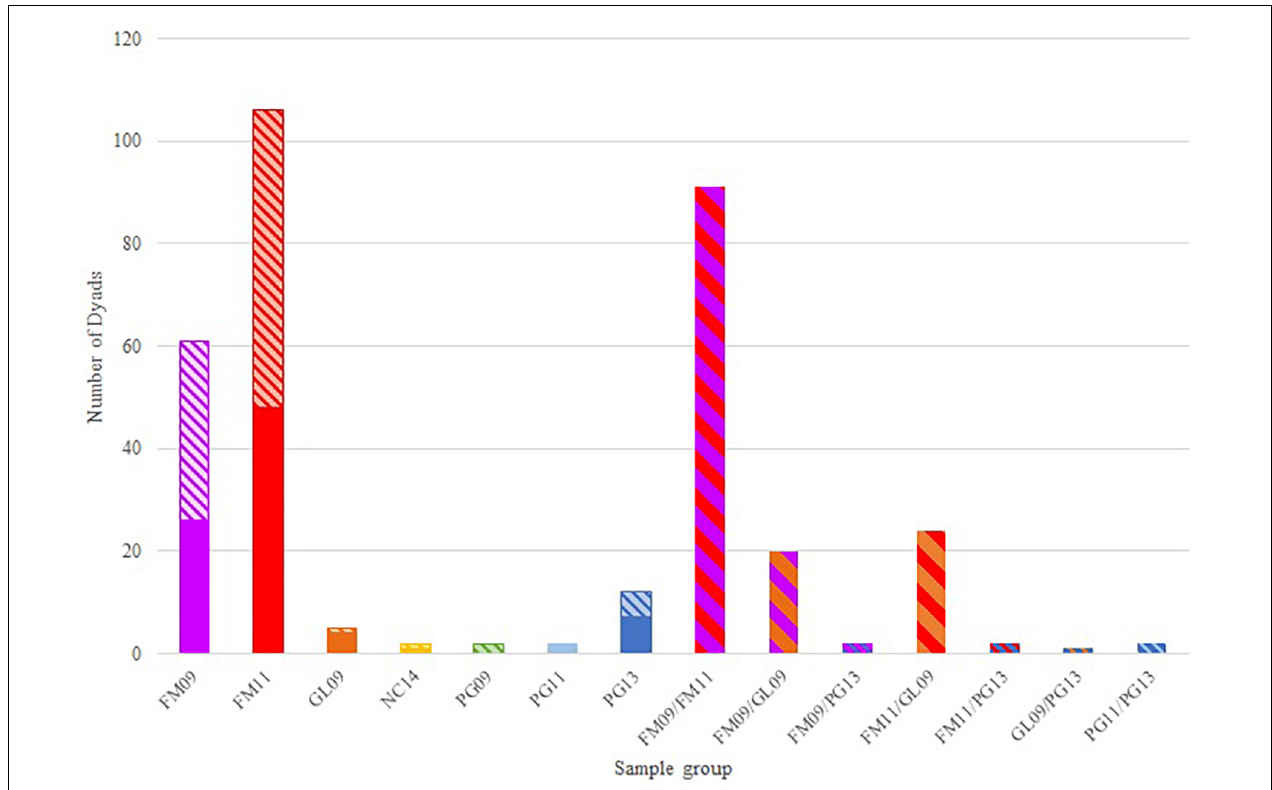
FIGURE 5 | All sibling dyads identified in each sample group, and between groups. Solid bars represent dyads from the same catch event, horizontally striped bars represent those from different catch events